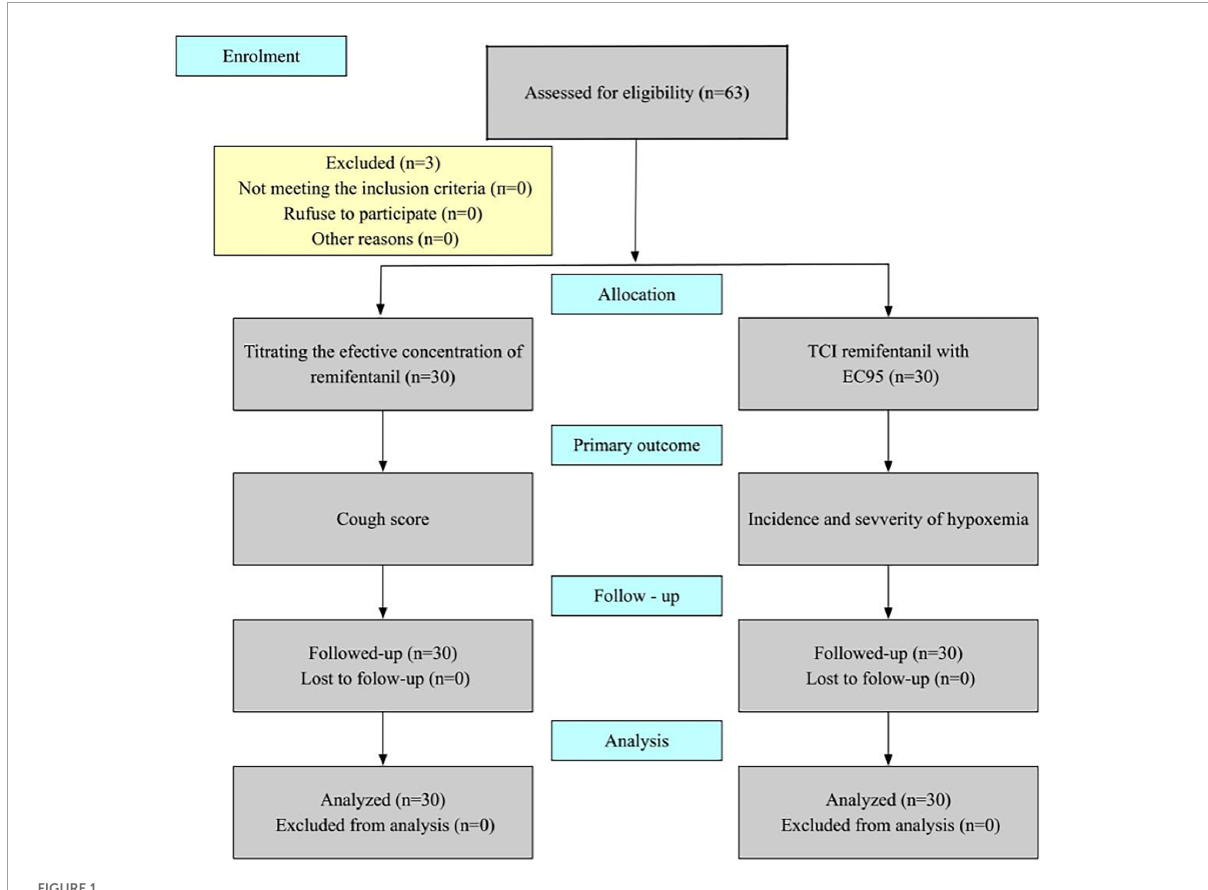
FIGURE1 Consort flow